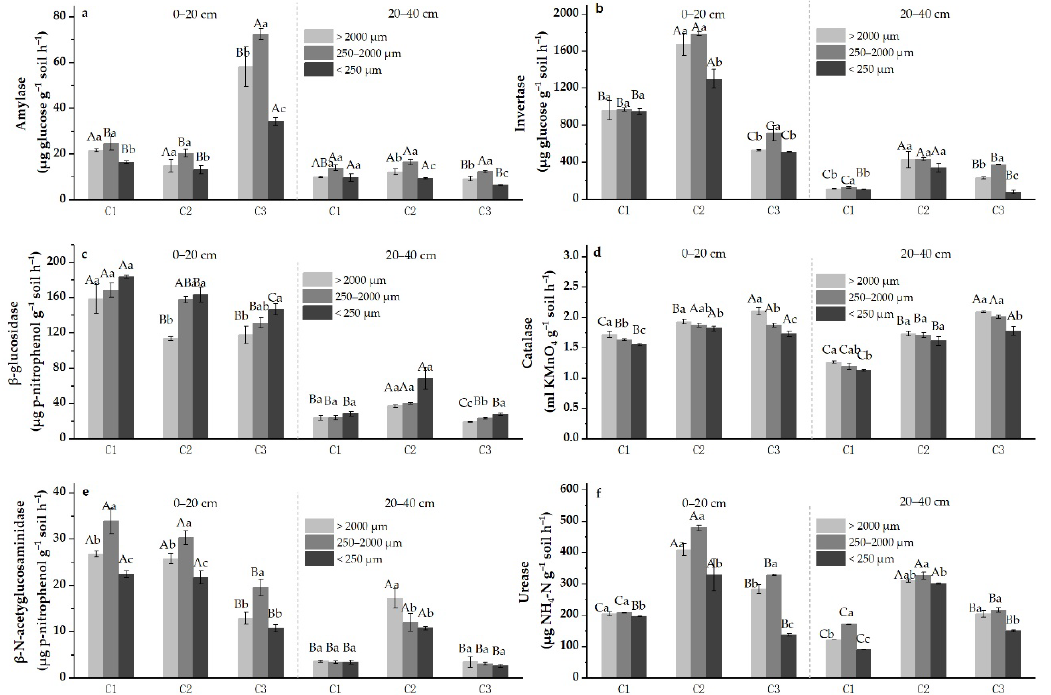
Figure 3. Soil enzyme activities in aggregate fractions with a depth of 0–20 cm and 20–40 cm (n = 3). Capital letters indicate significant differences among plots, while lower letters indicate significant differences among aggregate fractions ( p < 0.05). C1, C2, and C3 were the sample plots in the study.